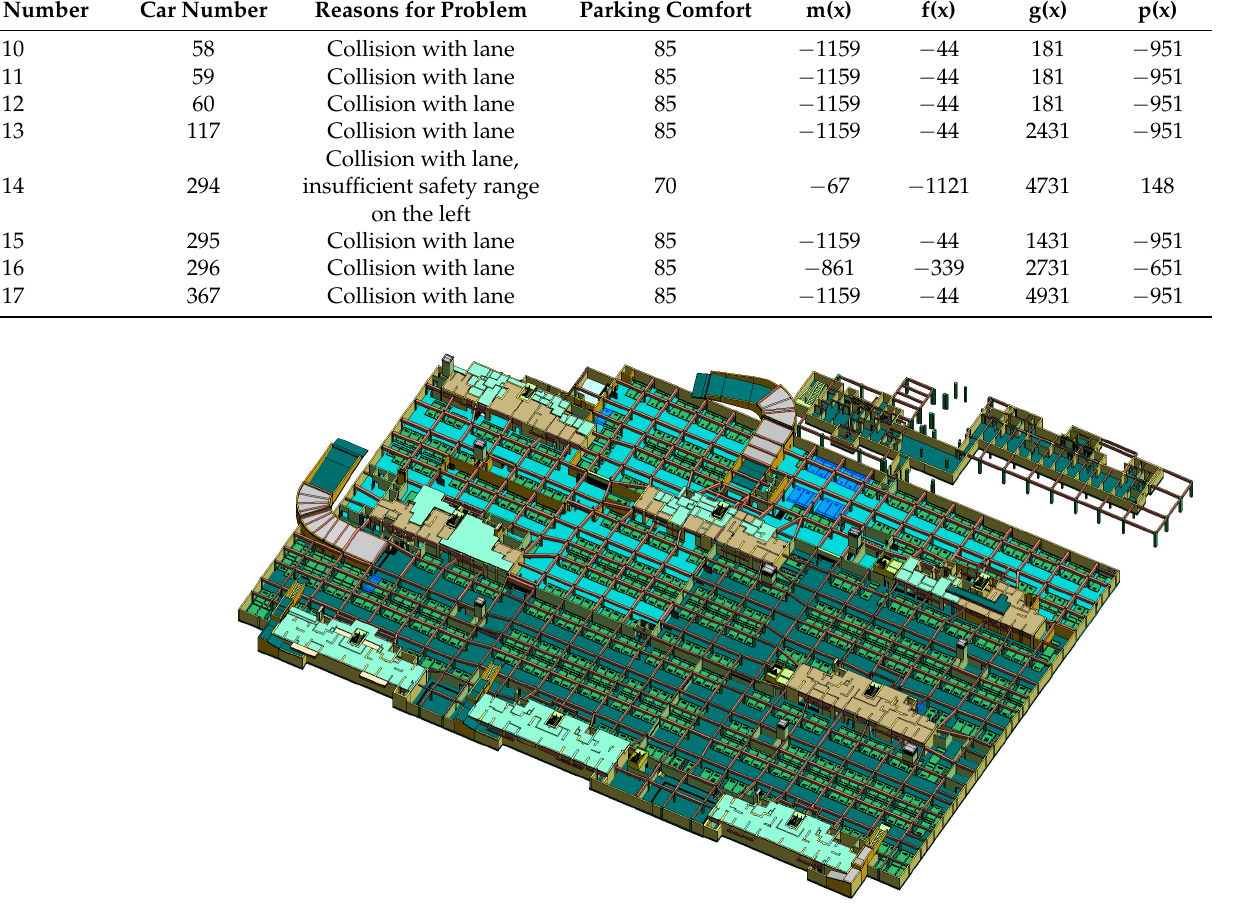
Figure 8. Parking adaptability test results of an underground garage. Table 1. Value of the parking space constraint model with poor comfort.